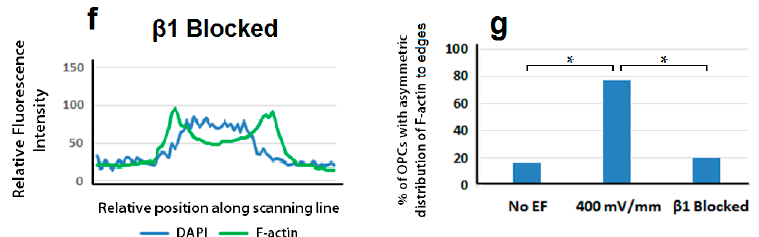
Figure 3. Asymmetric rearrangement of actin in electrotactic OPCs. Without exposure to an EF, there is no obvious asymmetric distribution of actin in OPCs ( a ); Results show an asymmetric reorganization of actin towards the leading edge of rat OPCs following exposure to a 400 mV/mm EF ( b ); Actin localization was observed to be similar in both OPCs that were not EF-treated, and OPCs that were exposed to a 400 mV/mm EF with β 1 integrin inhibition ( c ); A fluorescence intensity scan measures the average fluorescence along three lines drawn at random positions in 30 different cells. Linear fluorescence intensity scans ( d – f ) were conducted along the yellow lines (shown as examples) in the images ( a – c ), respectively. The relative fluorescence intensities generated by ICC-stained DAPI and F-actin were analysed and compared under each experimental condition: no EF ( d ); 400 mV/mm EF ( e ) and 400 mV/mm EF with β 1 integrin inhibition ( f ); Quantification results of OPCs with asymmetric rearrangement of F-actin to the leading edge of migrating cells ( g ). Statistical analysis (by χ 2 -test) indicates that the observed differences in asymmetric F-actin distribution between OPCs from the EF group, and OPCs from the groups No EF and EF with β 1 inhibition, are both significant (* p < 0.05). Composite images ( a – c ) are merged images consisting of 3 channels: F-actin ( green ), Olig2 ( red ), and DAPI ( blue ). Scale bar = 50 µ